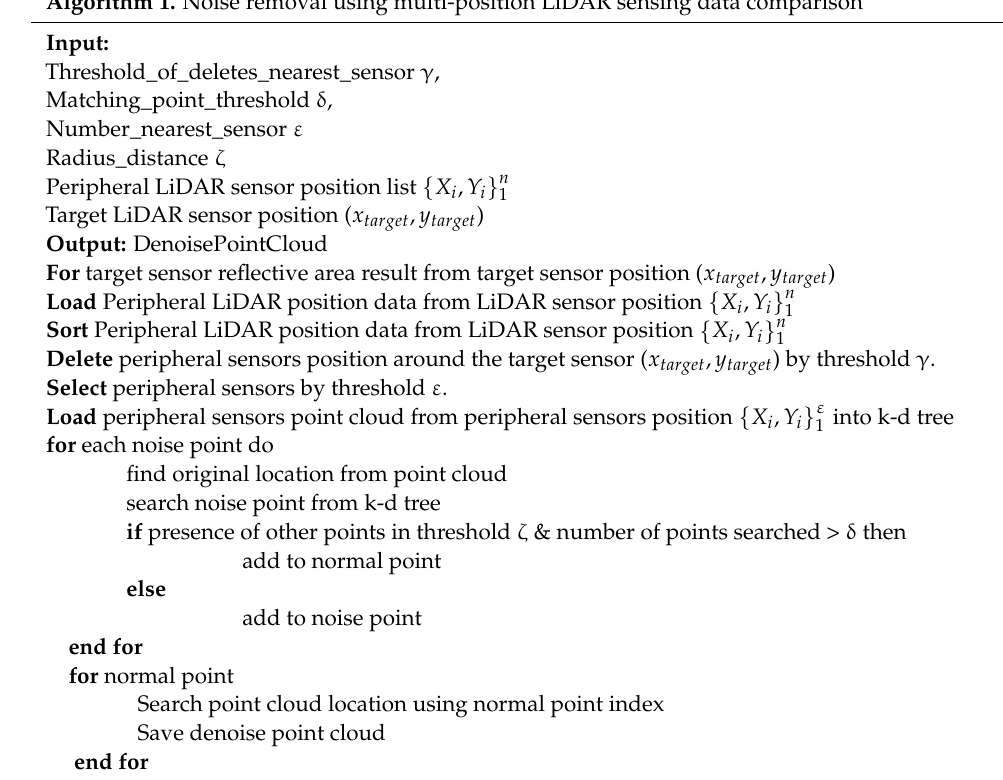
Algorithm 1. Noise removal using multi-position LiDAR sensing data